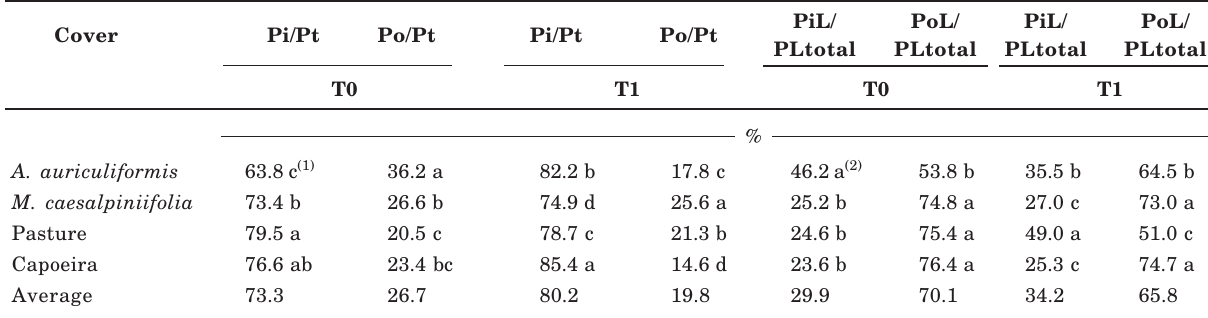
Table 3. Percentage distribution of total inorganic (Pi), total organic (Po), labile inorganic (PiL) and organic (PoL) phosphorus contents of soils under leguminous trees, pasture and capoeira at incubation time zero (T0) and after 90 d of incubation